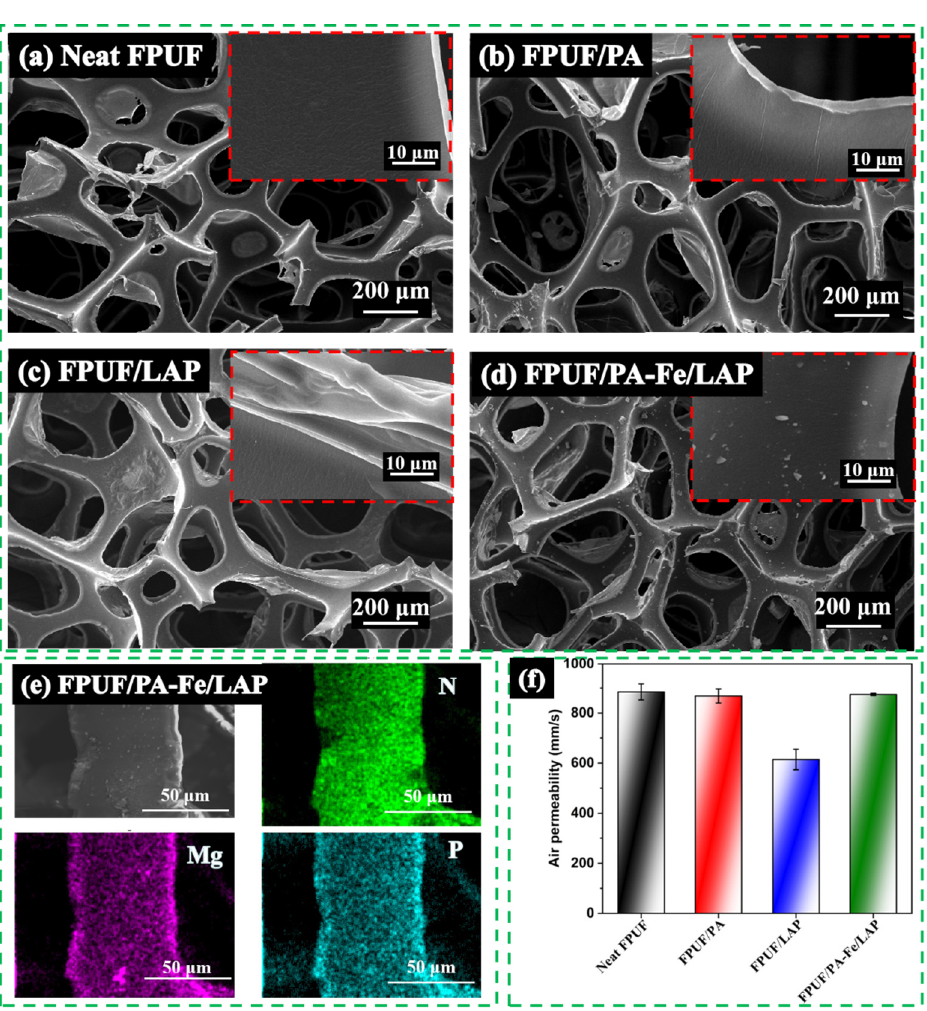
Figure 1. SEM images of neat FPUF ( a ), FPUF/PA ( b ), FPUF/LAP ( c ), and FPUF/PA-Fe/LAP ( d ), EDX mapping images of FPUF/PA-Fe/LAP ( e ), and air permeability of FPUFs ( f ).